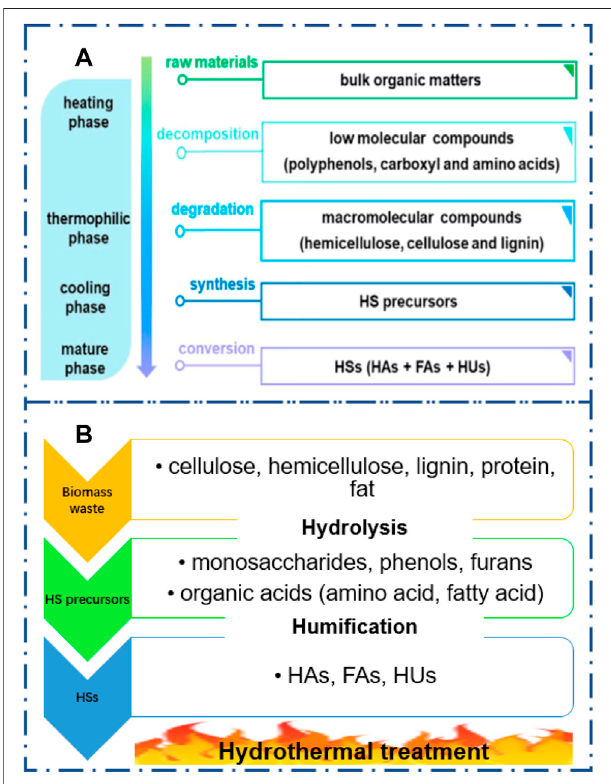
FIGURE 3 | Proposed mechanisms of humic substance formation during aerobic composting (A) and hydrothermal reaction (B) . (A) Reproduced from thework byGuo et al.(2019) withpermissionfrom Elsevier, copyright